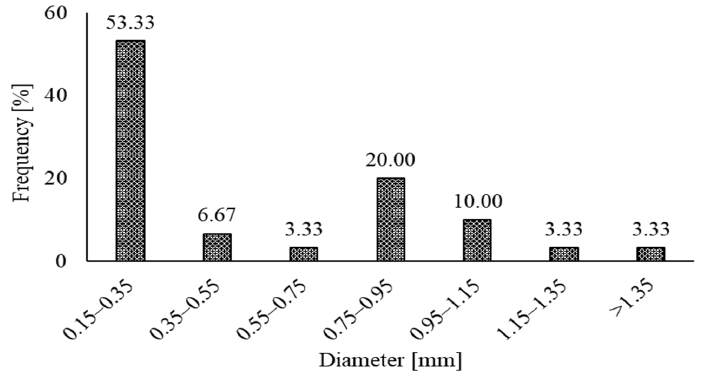
Figure 1. Frequency of RSFs for various ranges of diameters.